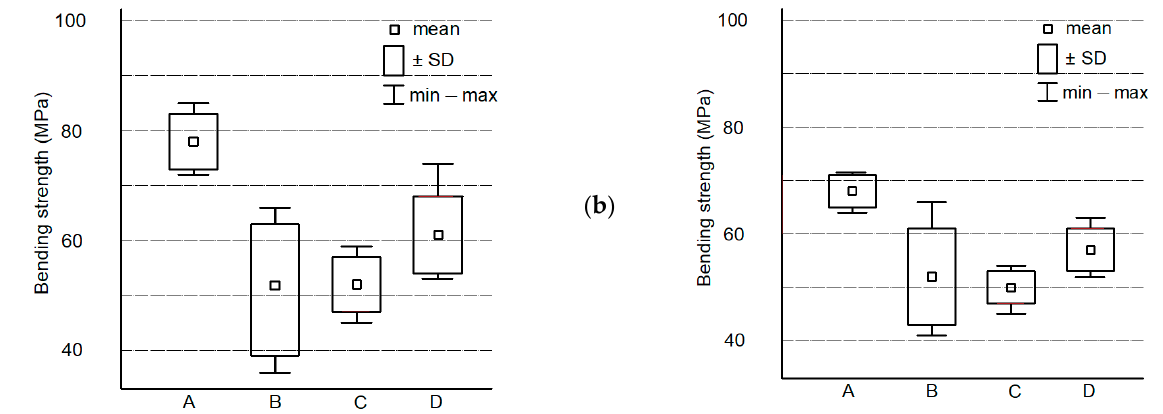
Figure 10. Results of static bending strength at T = 22 °C: ( a ) MC = 10%; ( b ) MC = 80%.